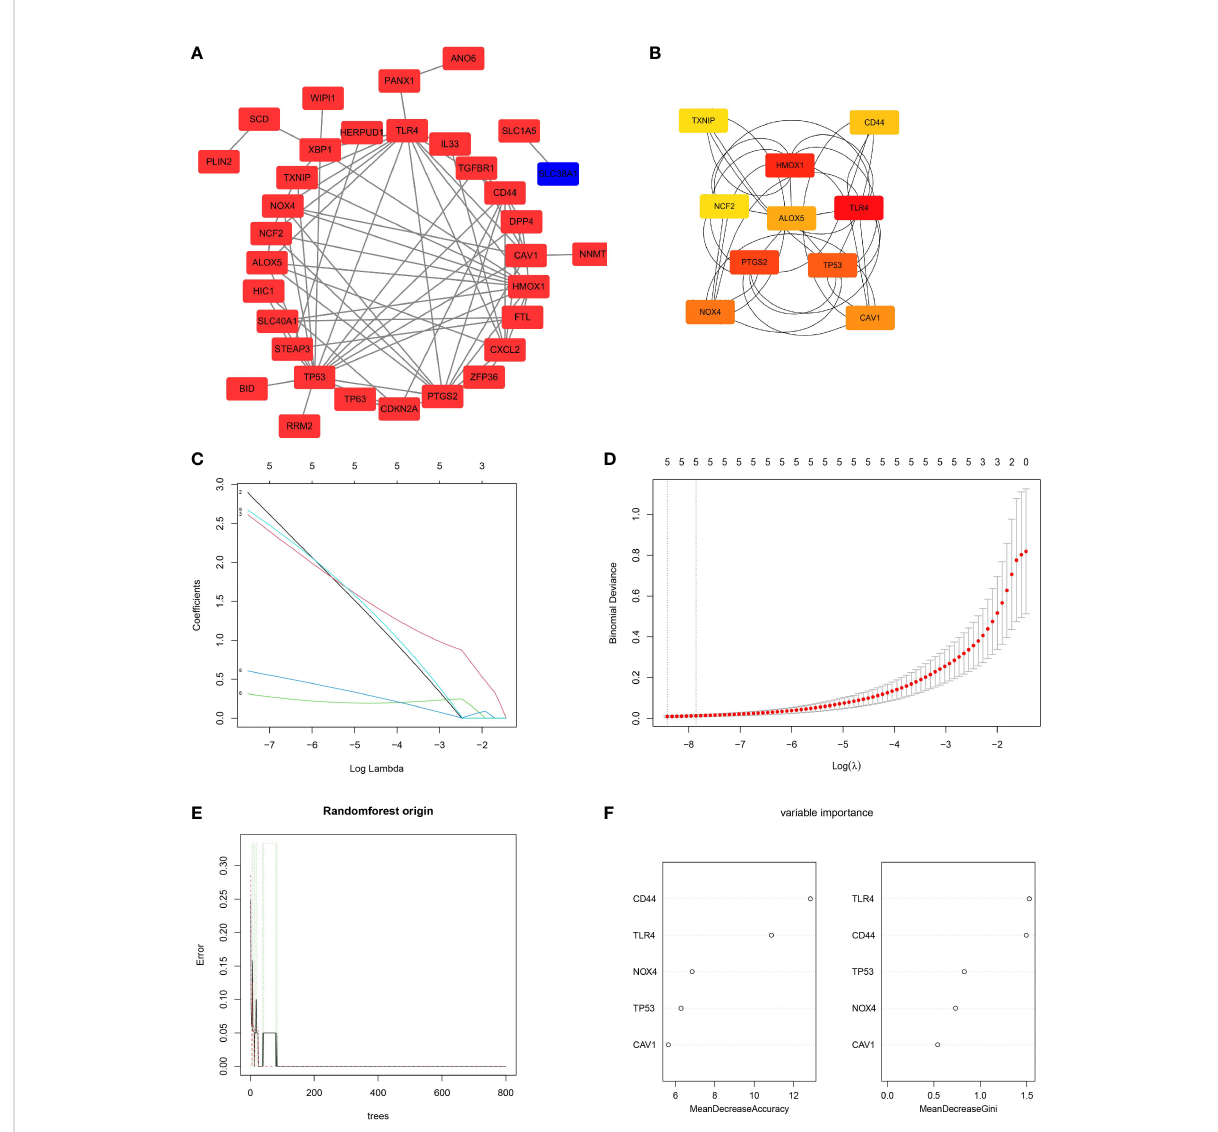
FIGURE 4 Protein-protein interaction (PPI) analysis and screening of ferroptosis-related hub genes (FRHGs). (A) The PPI network of ferroptosis-related DEGs. Red rectangles represent upregulated genes, while the blue rectangle represents a downregulated gene. (B) Network of the candidate FRHGs. A redder color represents a higher score in Cytoscape based on the MCC algorithm. (C, D) Least absolute shrinkage and selection operator (LASSO) regression algorithm to screen fi ve FRHGs. (E, F) Construction and evaluation of random forest model based on the fi ve FRHGs screened by LASSO regression. (E) Trend of the model errors based on the number of decision trees. (F) The importance of all variables in the random forest